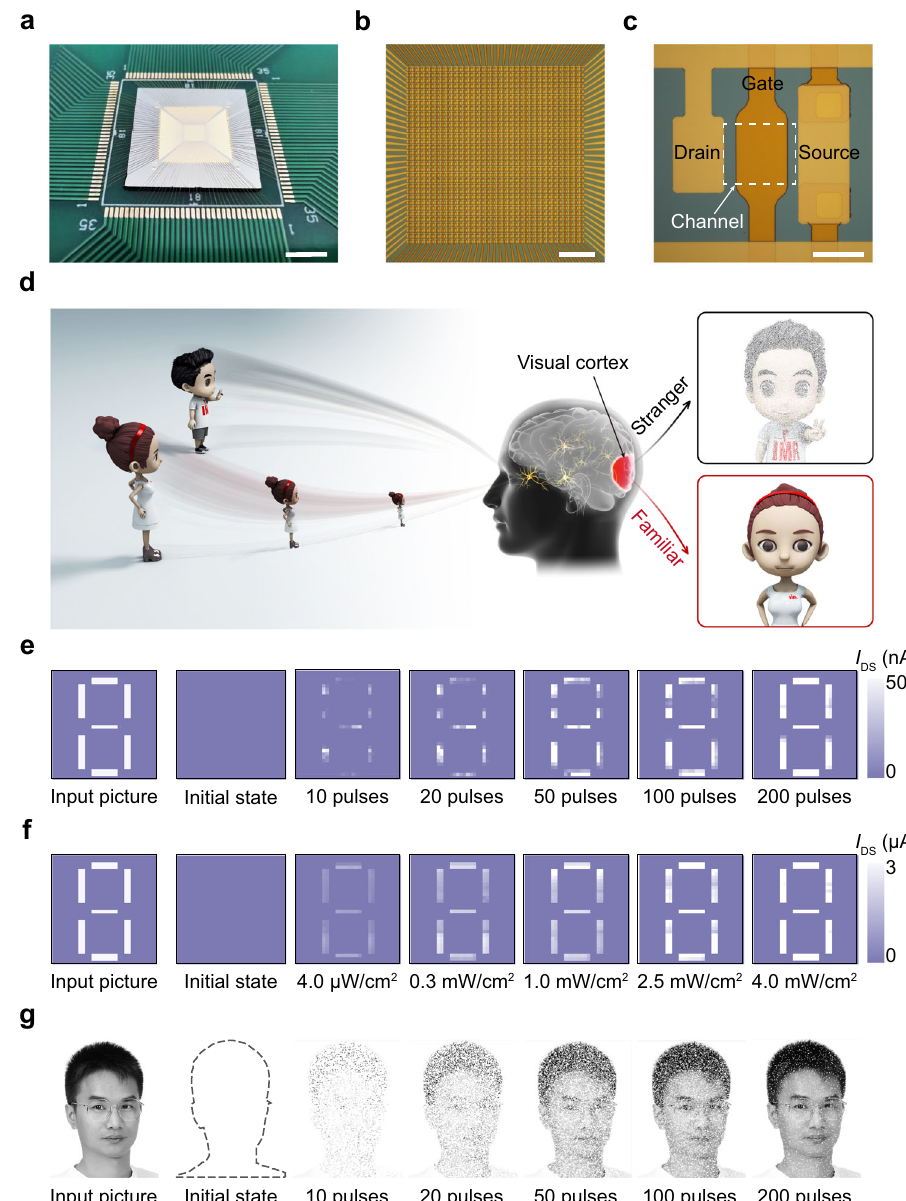
Fig. 3 Optoelectronic sensor array. a A sensor array chip with wire bonding on a PCB (scale bar, 5 mm). b Optical micrograph of a 32 × 32 sensor array (scale bar, 500 μ m). c Magni fi ed image of an individual sensor unit with a channel dimension of 20 × 20 μ m 2 (scale bar, 20 μ m). d Schematics of the impression of human visual systems when strange and familiar faces are observed. e Measured training weight results of a number 8 pattern in the initial state and after training with 10, 20, 50, 100, and 200 pulses under 405 nm light with a lighting power density of 1 μ W/cm 2 (pulse width, 250 ms; pulse interval, 250ms). f Measured training weight results of the sensor array after training with 10 pulses under a 405 nm light with various lighting power densities of 4.0 μ W/cm 2 , 0.3 mW/cm 2 , 1.0 mW/cm 2 , 2.5 mW/cm 2 , and 4.0 mW/cm 2 (pulse width, 250 ms; pulse interval, 250 ms). g Simulation results of a man ’ s face in the initial state and after training